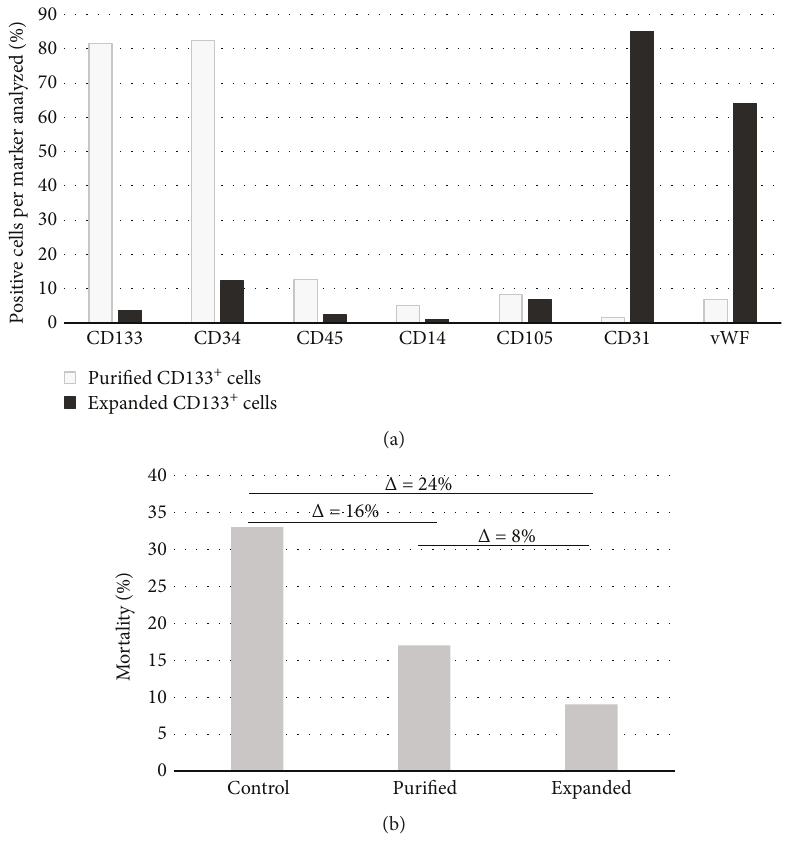
Figure 1: Expanded CD133 + cells acquired an endothelial-like immunophenotype and greatly diminished the mortality of rats with AMI. (a) Percentage of positive cells with progenitor and endothelial cell markers. Representative immunopro fi le of a sample of CD133 + cells isolated from human umbilical cord blood before (puri fi ed CD133 + cells) and after expansion (expanded CD133 + cells). (b) Percentage of mortality of the three groups: control (injected with isotonic saline solution, sodium chloride 0.9%), puri fi ed (transplanted with puri fi ed CD133 + cells), and expanded (transplanted with expanded CD133 + cells). The di ff erences between groups are expressed as the delta value ( Δ ) above the